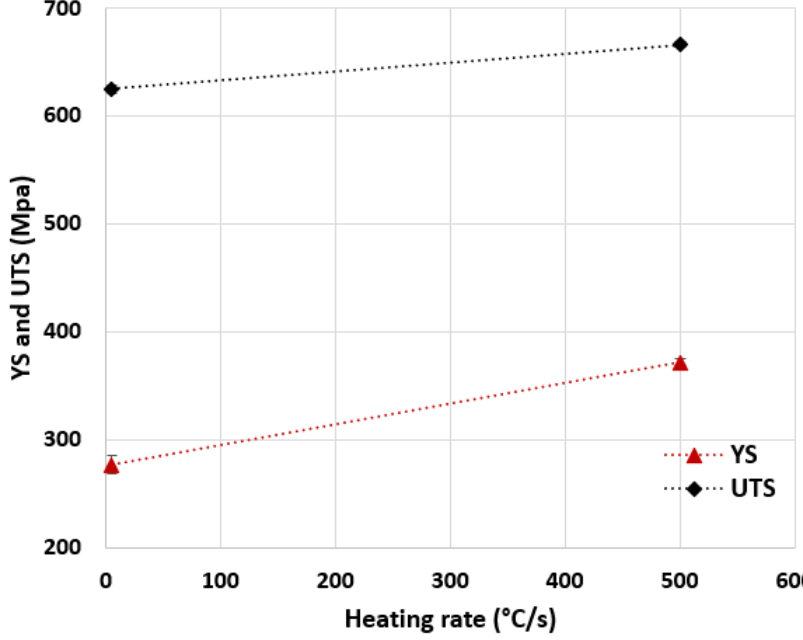
Figure 9. YS and UTS increase with increase in heating rate between CA (5 °C/s) and UFH (500 °C/s), on dual-phase steel (data from [41]).